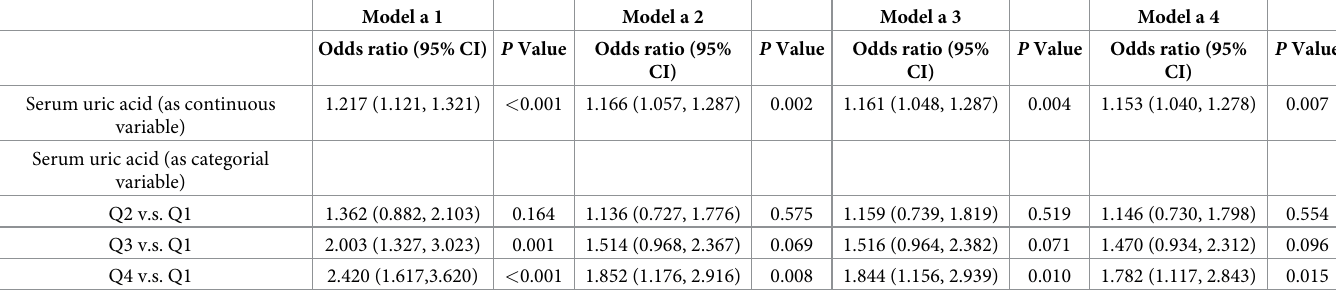
Table 3. Association between the serum urine acid and risk of